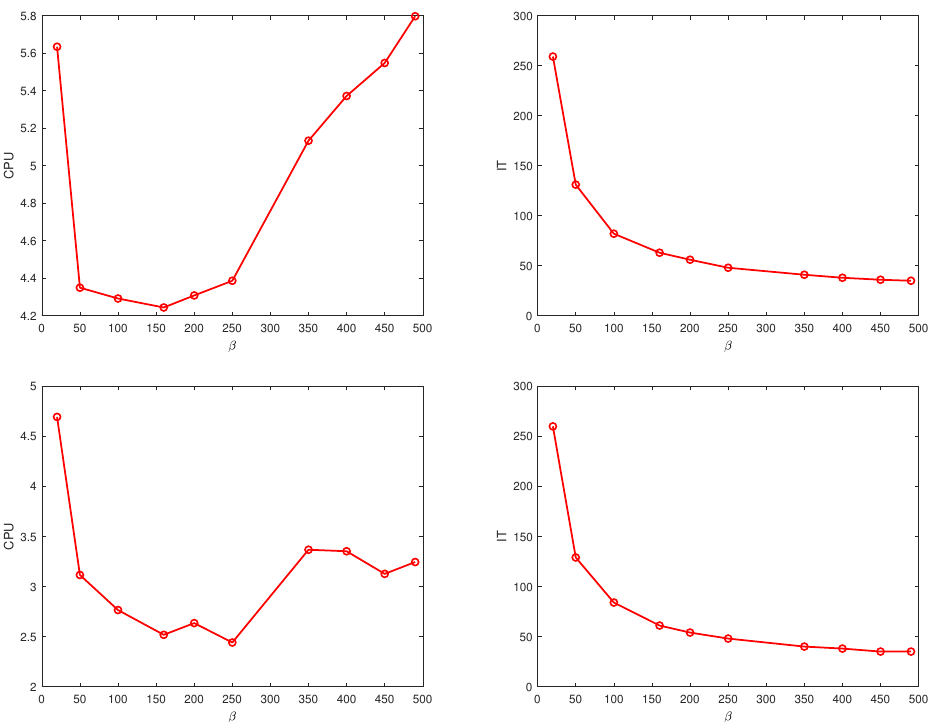
Figure 4. CPU and IT of the TRAKS and TRAKS F algorithms for different β . Upper : TRAKS. Lower : TRAKS F .